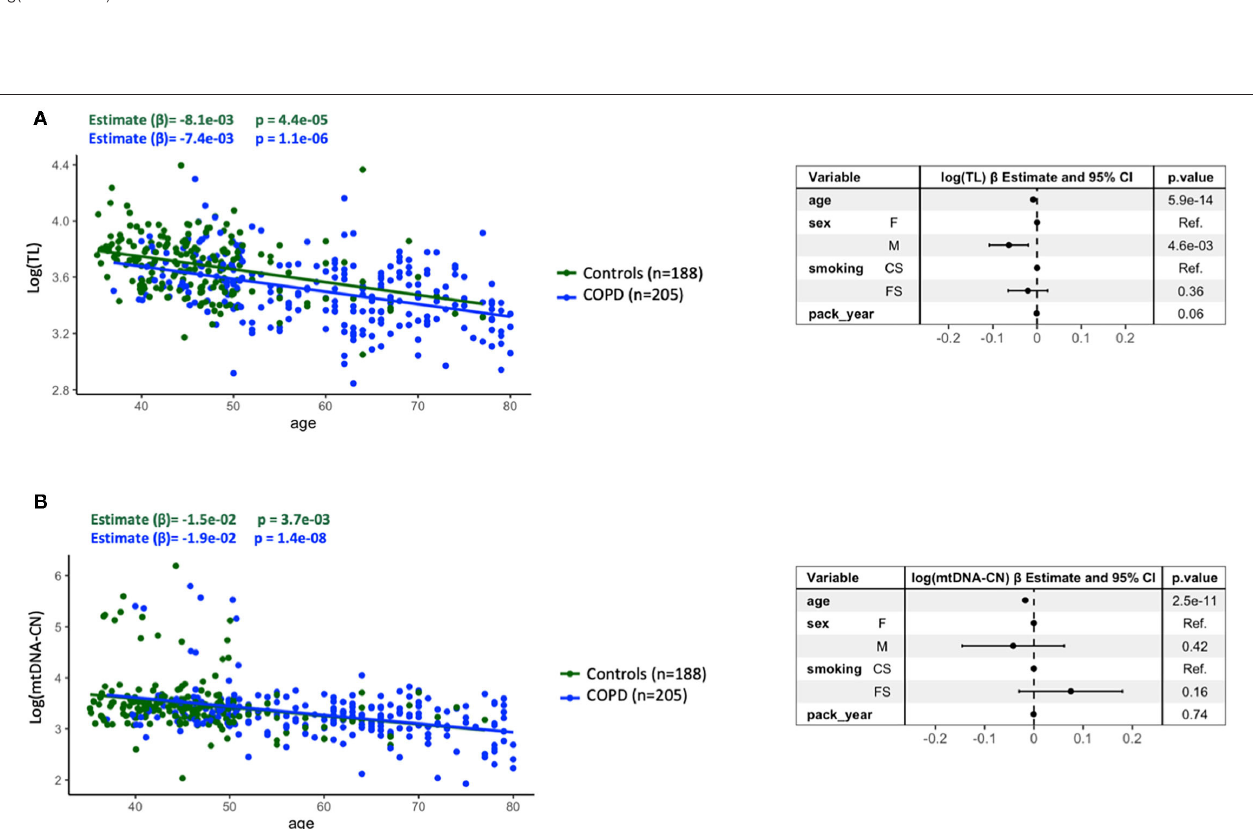
FIGURE 1 | Relationship between telomere length [log(TL)] (A) or mitochondrial DNA copy number [log(mtDNA-CN)] (B) , both log transformed, and age in the entire study population, stratified by controls ( n = 188) (green dots and line) and patients with COPD ( n = 205) (blue dots and line). Forest plots of the linear regression models of all individuals ( n = 393) presenting the point estimates and 95% CI (whiskers) of the change in log(TL) or log(mtDNA-CN) when adjusted for the potential confounders. For further explanations, see text.